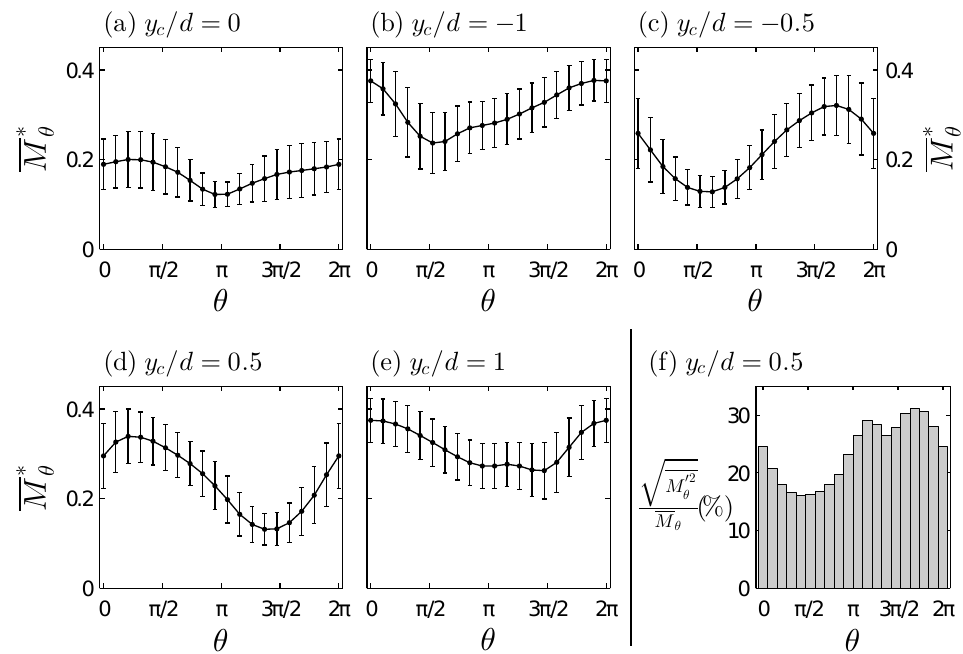
∗ 2 = M with the azimuthal angle θ for different values of y c θ / ρ d ¯ u θ h (cid:113) M (cid:48) 2 non-dimensionalized with ρ d ¯ u 2 θ